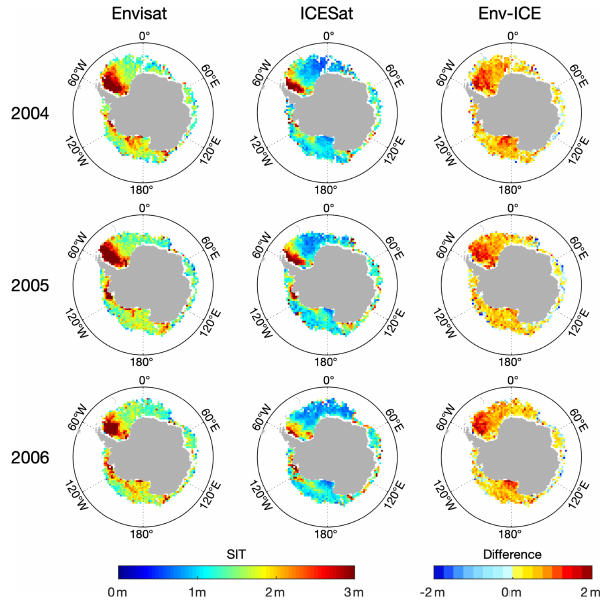
Figure 6. Same as Fig. 4 but for autumn (May and June).